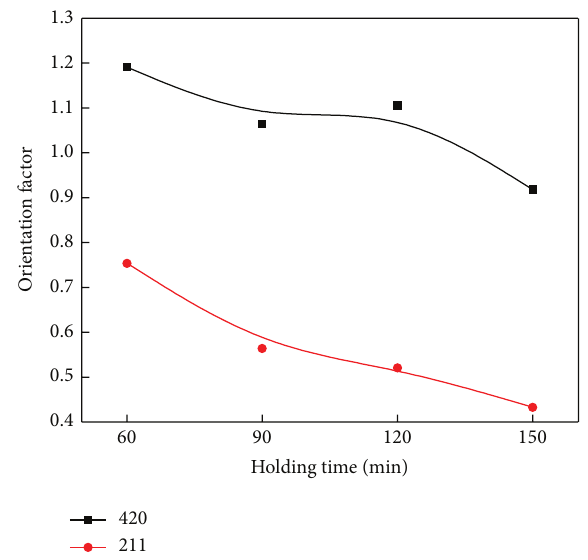
Figure 5: Effect of synthesis time on preferred oriented factor of crystal